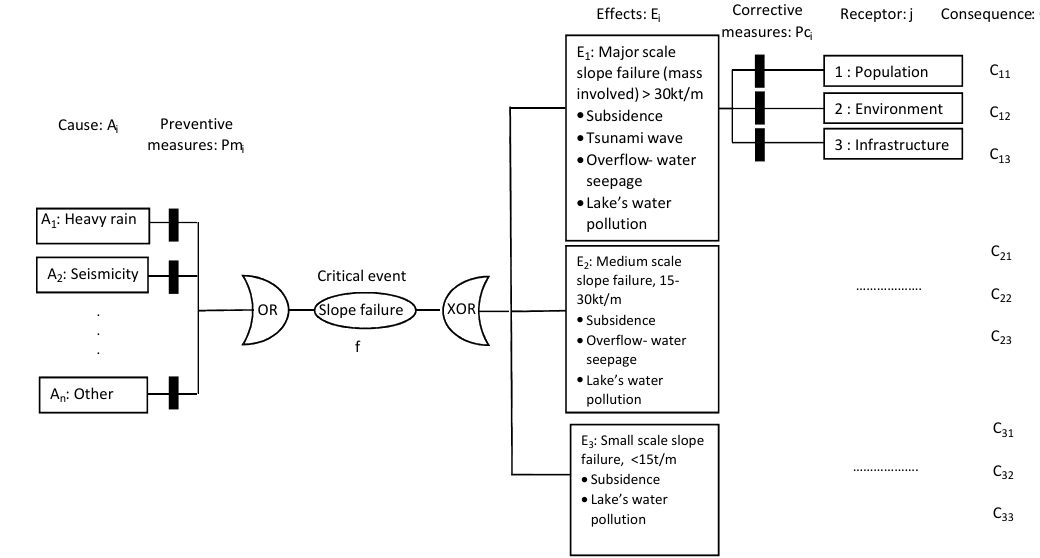
Figure 1. Bow-tie analysis of slope failure of pit